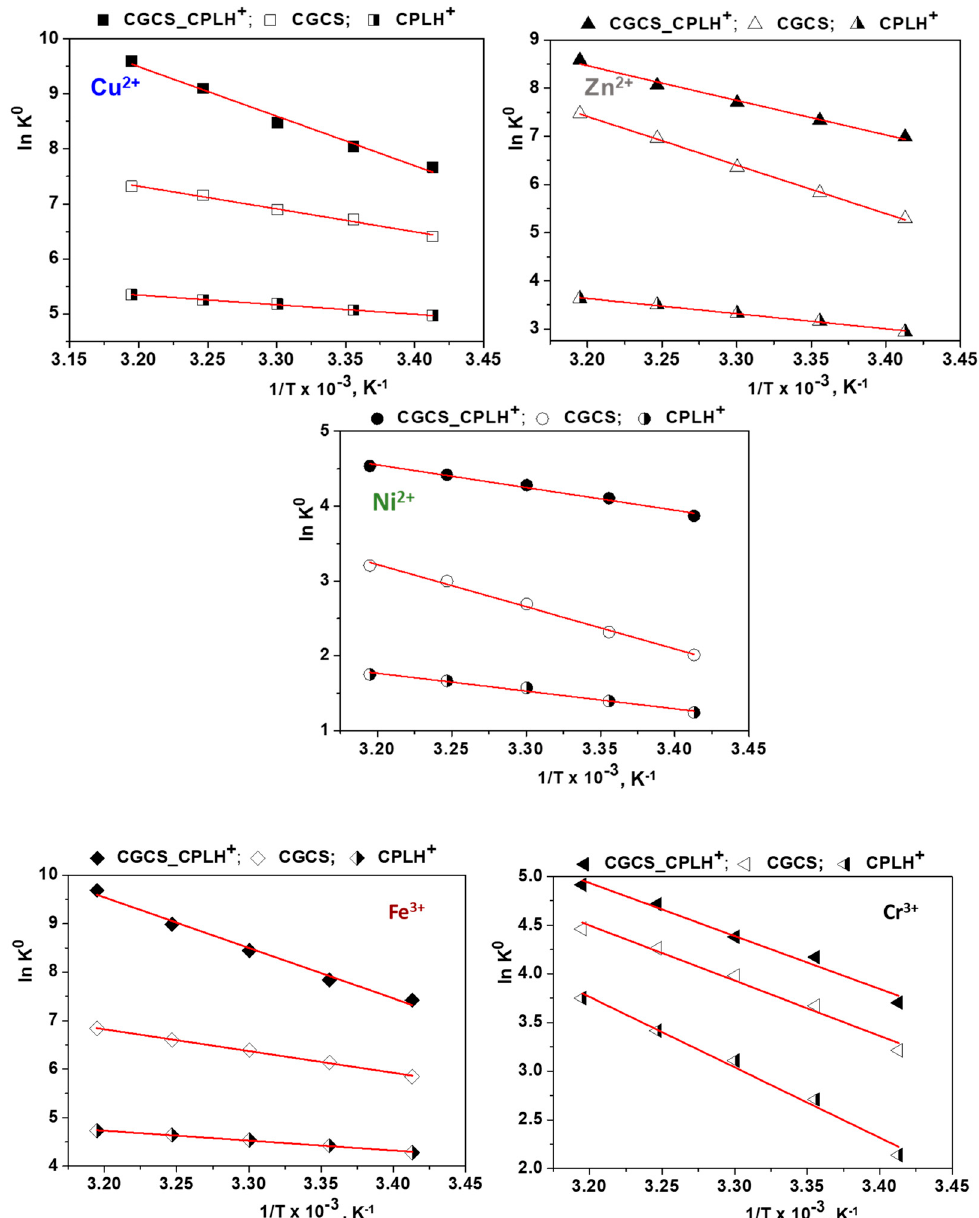
Figure 6. Plot of lnK o versus 1 / T for the sorption of Cu 2 + , Zn 2 + , Ni 2 + , Fe 3 + , and Cr 3 + ions onto CS-based sorbents.